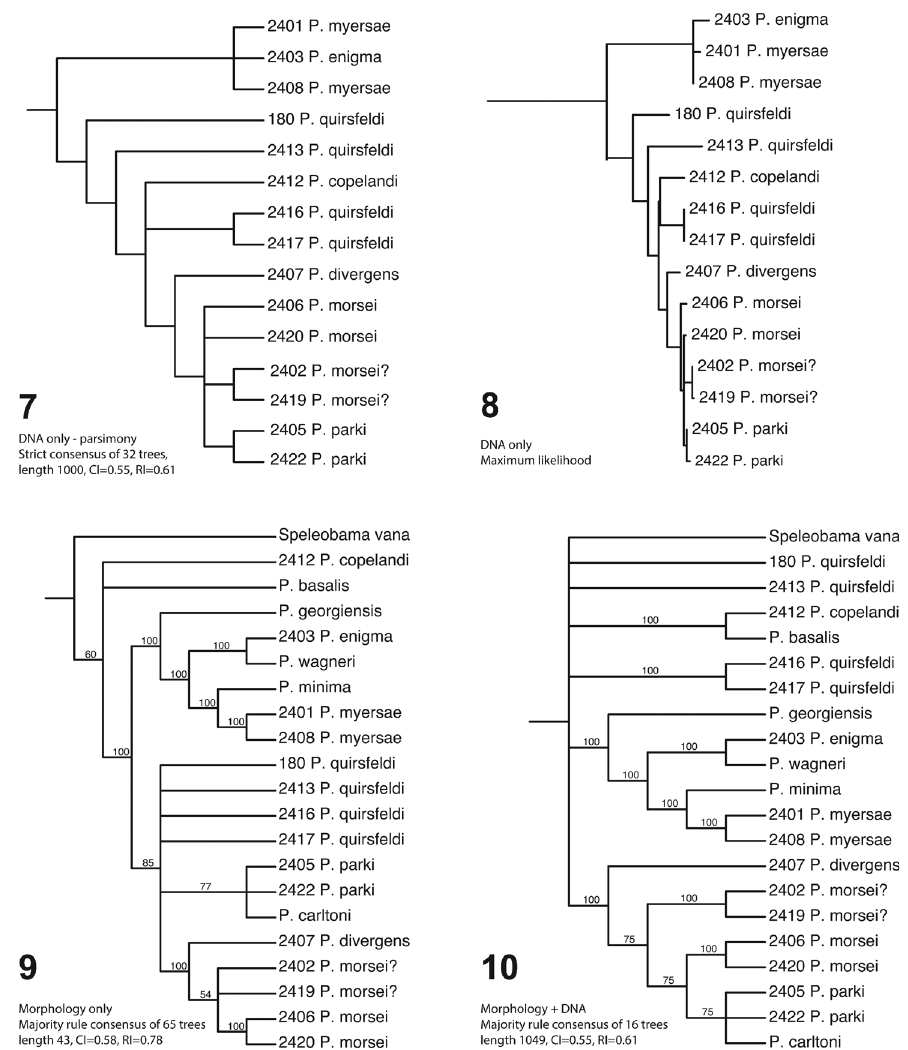
Figures 7–10. Phylogenetic hypotheses based on: 7 Parsimony analysis of DNA only 8 Maximum likelihood analysis of DNA only 9 Parsimony analysis of morphology only 10 Parsimony analysis of morphology and DNA combined. Numbers on terminal taxa refer to DNA extraction